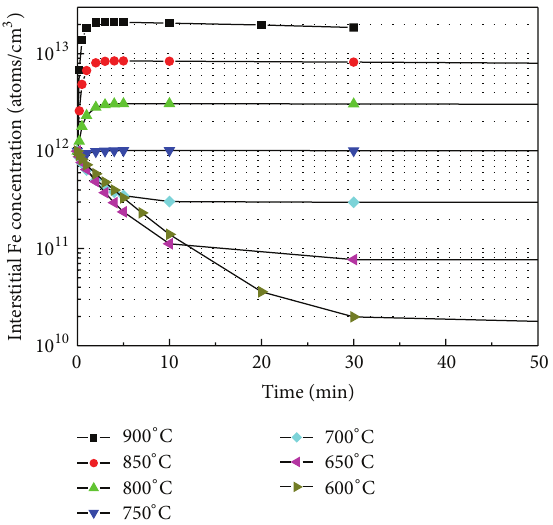
Figure 2: Calculated total Fe concentration averaged throughout the Si wafer after the gettering process with different temperatures and times. The initial concentration of the total iron atoms was assumed to be 1 × 10 15 atoms/cm 3 . The total Fe concentration decreased more rapidly with gettering time for higher temperature.